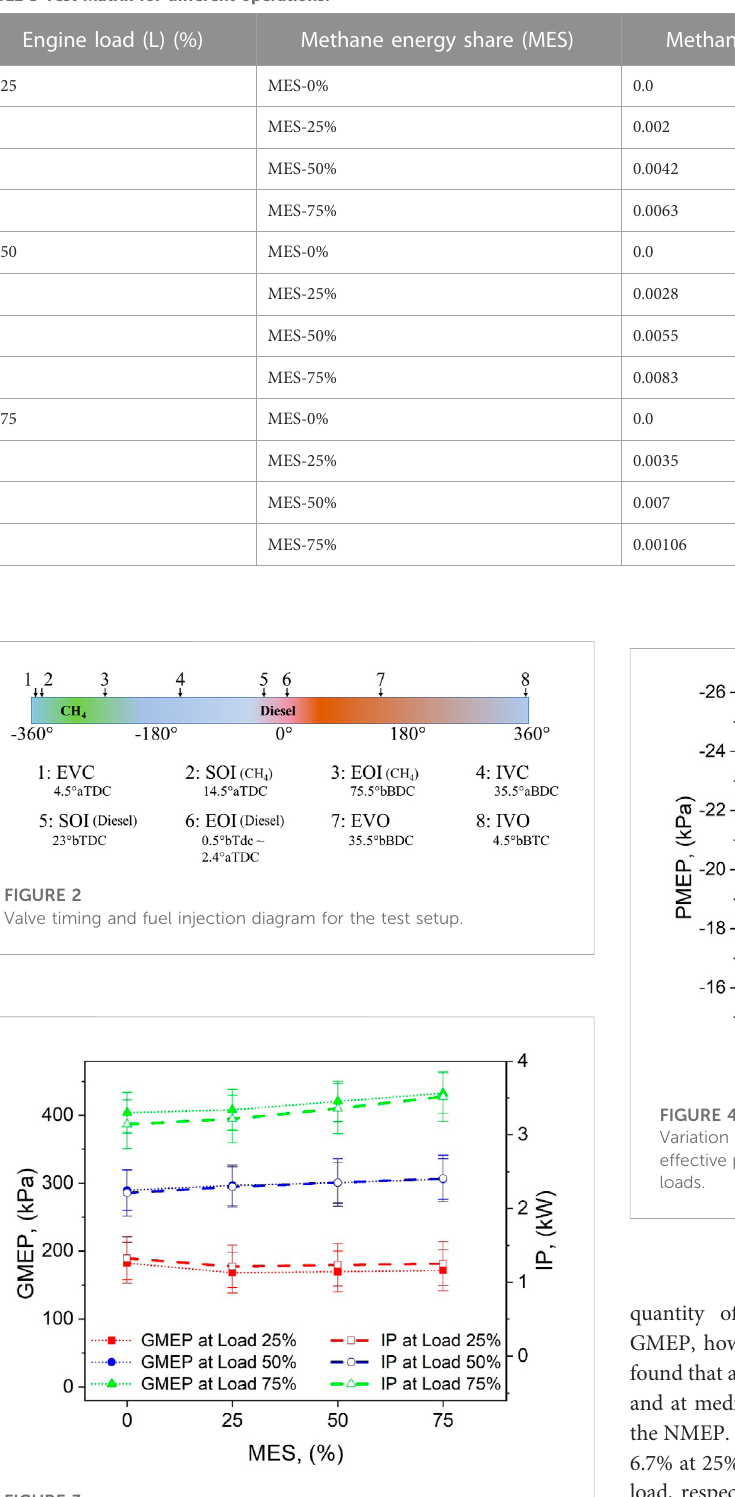
FIGURE 3 Variation of gross mean effective pressure and indicated power with respect to diesel fuel with MES level at different loads.